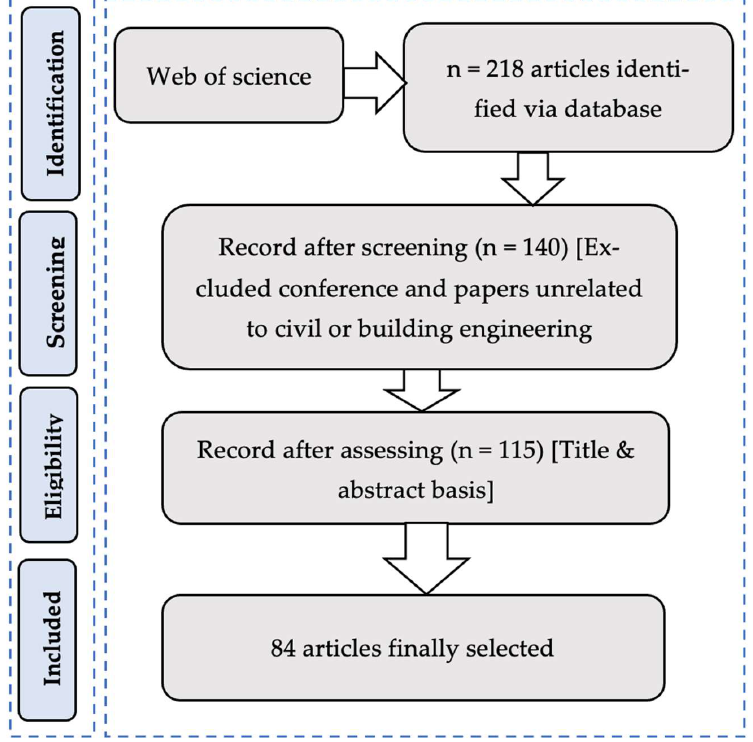
Figure 2. Research methodology.